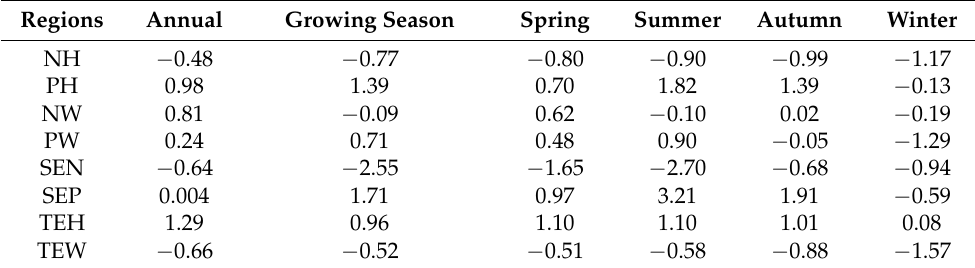
Table 5. Vegetation trends in different function types in Central Asia (unit: 10 − 3